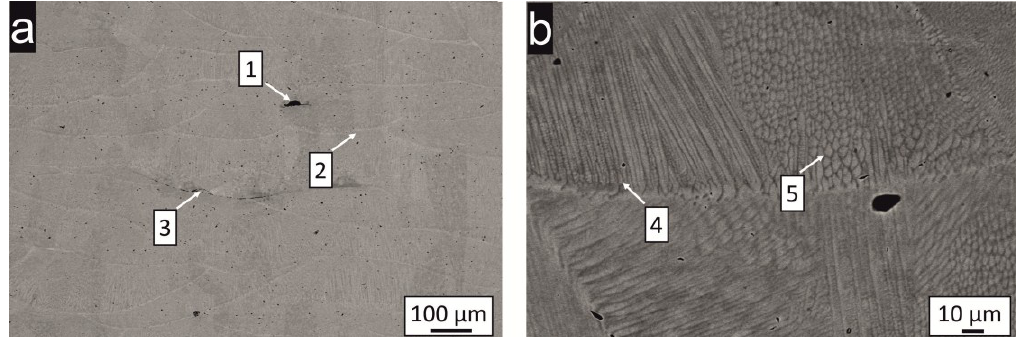
Figure 3. Scanning electron microscopy images of the SLM sample produced with the following parameter set: laser speed, 35 mm/s; power, 250 W and hatching overlap, 50% (Back scattered electron mode, ( a ) 10 kV ( b ) 20 kV, etchant: Kroll’s